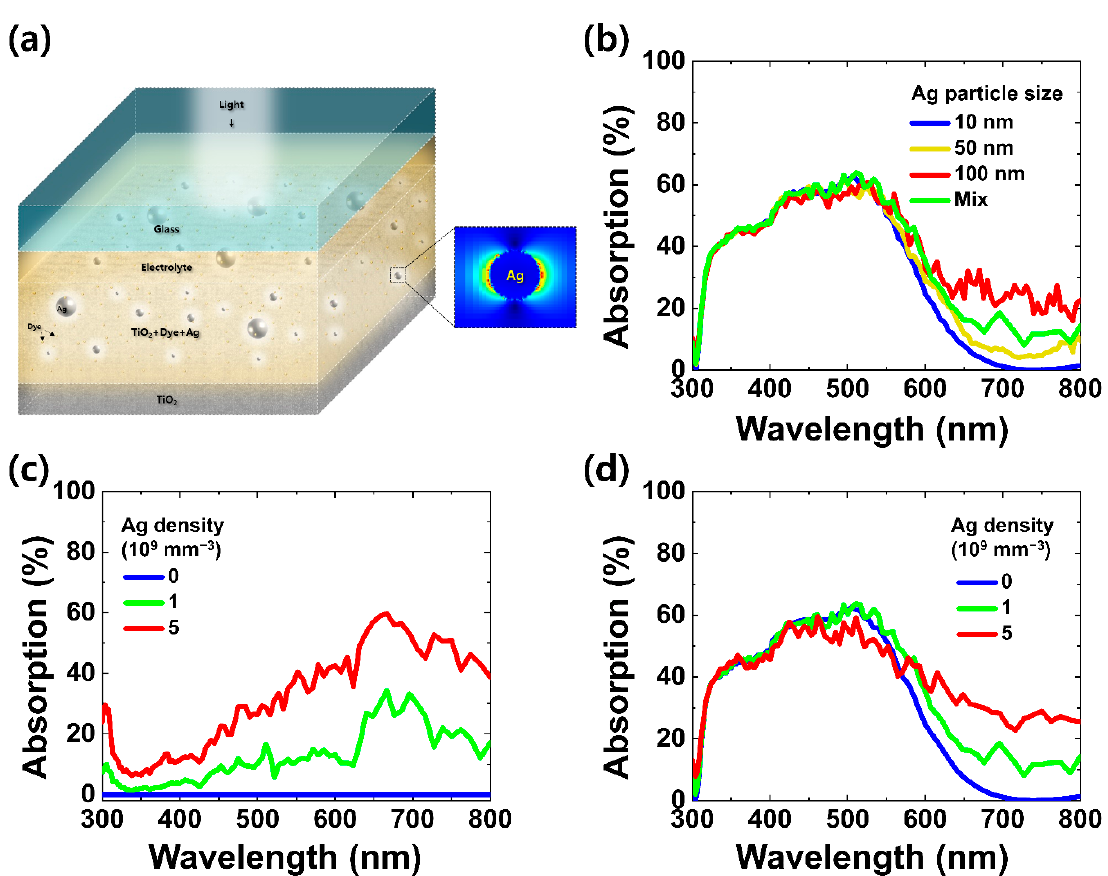
Figure 2. FDTD simulation of Ag-particle effects in the DSSC: ( a ) illustrated image of DSSC structure, ( b ) absorption spectra of active layer for the different Ag particle sizes, and absorption at ( c ) Ag particles and ( d ) at an active layer for the different Ag densities.